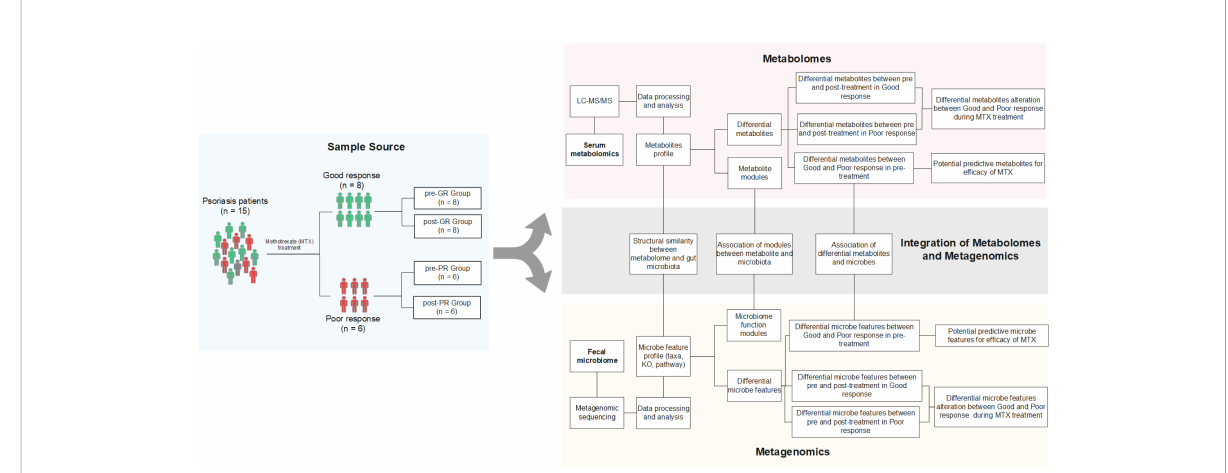
FIGURE 1 Schematic diagram of the study design. Fifteen patients with psoriasis underwent 16 weeks of MTX therapy and then their clinical improvement was assessed. Eight subjects were assigned to the good response group [at least 75% improvement in PASI (PASI ≥ 75)], while six subjects were assigned to the poor response group [less than 50% improvement (PASI < 50)]. Only one was categorized between these two groups. Fecal samples and blood samples of all 15 patients were collected before and after the treatment. The fecal samples were further investigated by metagenomic sequencing, and the biological information, such as community composition, KO genes, and pathway pro fi les, was extracted. Metabolites in blood samples were analyzed using an untargeted LC-MS/MS approach. Both omics data were used to screen for the signature associated with differential ef fi cacy. Paired-sample comparison between the pre- and post-treatment was also performed. Further integration of the two omics data occurred on three levels: (i) assessment of the structural similarity between metabolome and microbiota pro fi le (by Procrustes analysis); (ii) correlation analysis between the signatures mentioned above (Spearman rank correlations); and (iii) correlation analysis between microbial function modules and blood metabolite clusters